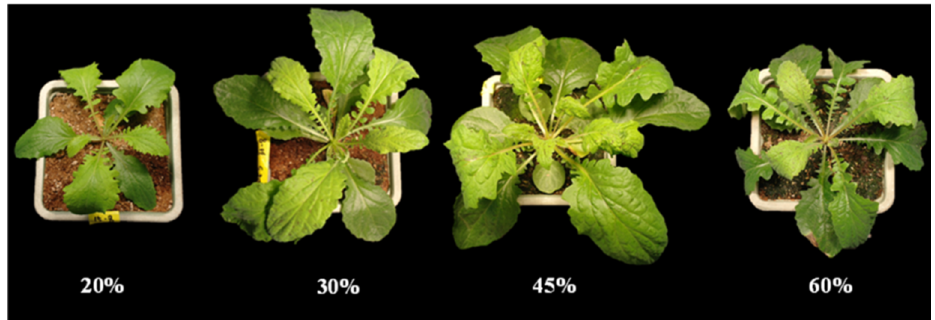
Figure 3. Crepidiastrum denticulatum grown under different substrate water content levels at 5 weeks after transplanting.